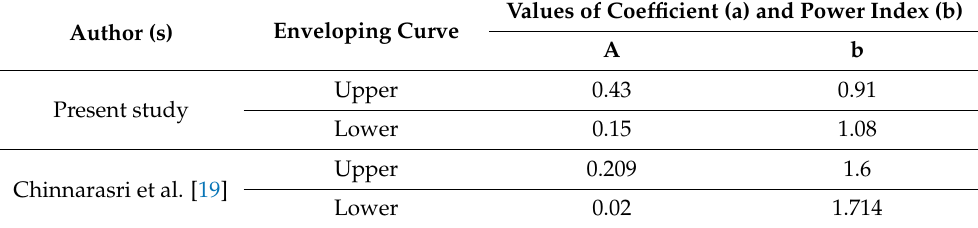
Table 3. Summary of coefficient and power index of Equation